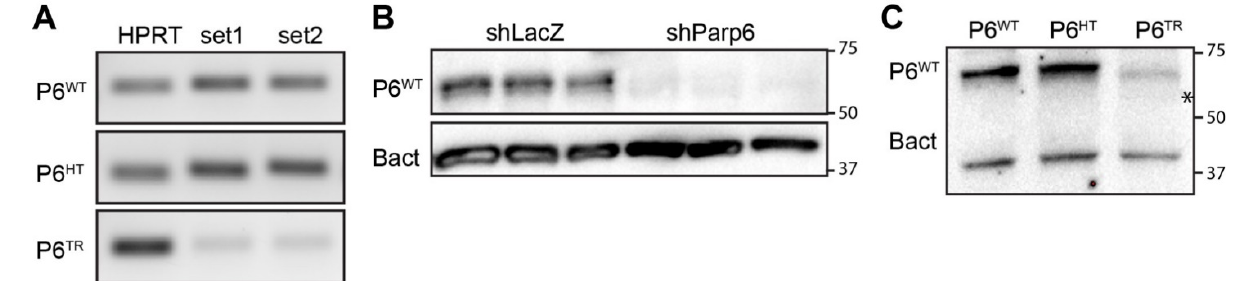
Figure 2. CRISPR-generated Parp6 mutation significantly reduces the levels of full-length Parp6 transcripts and protein compared to Parp6 wild-type and heterozygous animals. ( A ) RT-PCR image of Parp6 WT and Parp6 TR transcripts levels relative to mouse HPRT control, showing a significant reduction in 5 ′ Parp6 transcripts in the CRISPR mutants compared to Parp6 WT and Parp6 HT (one-way ANOVA, p < 0.0001, intensity of bands, n = 4). ( B ) Validation of Parp6 antibody using lysates from cortical neuronal cultures transduced with shParp6 or shLacZ control. Parp6 protein levels relative to β -actin show a significant 97.3% reduction in PARP6 in the shParp6 cortical neurons compared to shLacZ transduced neurons (shLacZ = 0.646 ± 0.067, shPARP6 = 0.017 ± 0.008; t -test p < 0.0007, n = 3). ( C ) Western blot showing expression of full-length Parp6 relative to β -actin (Parp6 WT = 2.037 ± 0.037, Parp6 HT = 2.141 ± 0.371, and Parp6 TR = 0.320 ± 0.157, mean ± SEM, n = 2) indicating a significant reduction in Parp6 protein in the CRISPR mutants. (*) indicates where the truncated Parp6 protein would be (predicted 57 KDa).